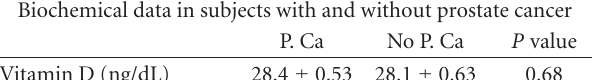
Table 2: Biochemical data in subjects with prostate cancer com- pared to age matched controls without Prostate